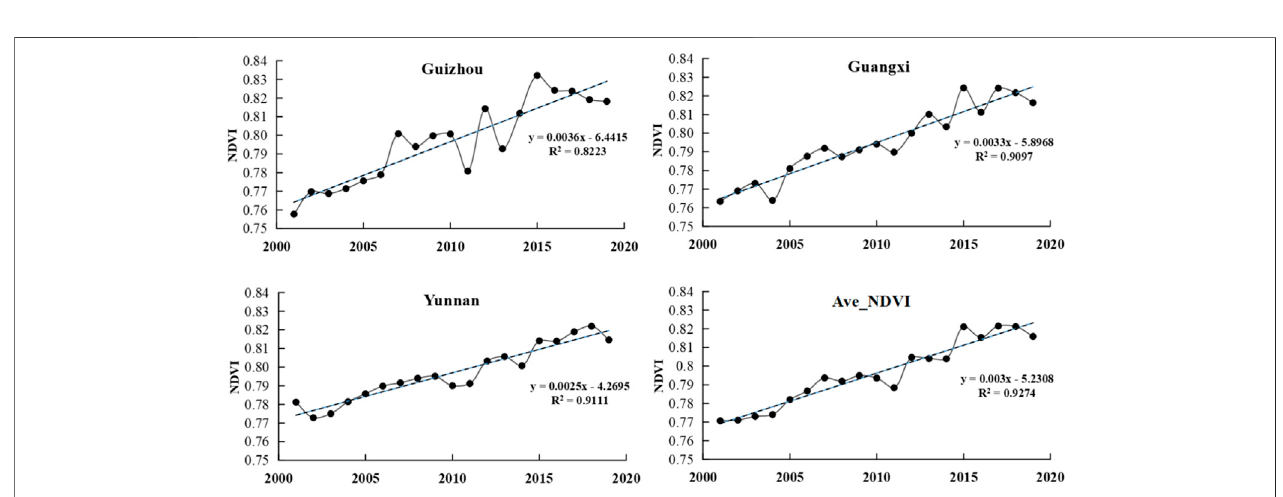
Frontiers in Earth Science |